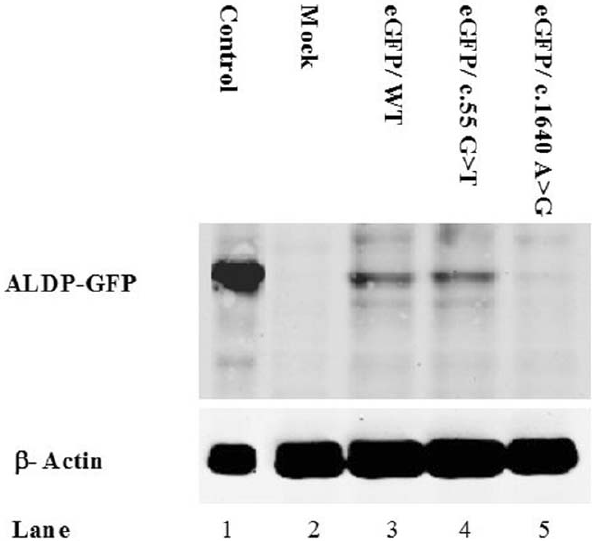
Figure 1. Western blot analysis of transient tranfected X-ALD fibroblasts. Each line was loaded with the same amount of total protein extracts, as verified with anti- b -actin protein. Line 1: healthy fibroblasts, line 2: X-linked adrenoleukodystrophy fibroblasts, line 3: fibroblats expressing wild type ALDP-GFP, line 4: fibroblats expressing ALDP-GFP (c.55G . T, p.Ala19Ser), line 5: fibroblats expressing ALDP-GFP (c.1640A . G, p.Tyr547Cys).